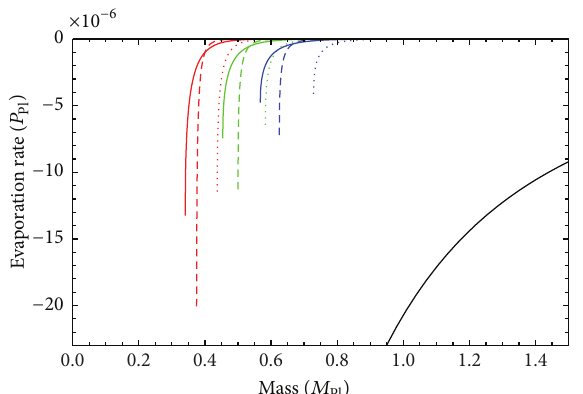
Figure 9: The evaporation rate versus the black hole mass for the case 𝑛 = 2 . From left to right: GUP 2 result (solid curve), GUP 0 result (dashed curve), and GUP 1 result (dotted curve) for 𝛼 = 0.75 (red), 𝛼 = 1 (green), and 𝛼 = 1.25 (blue), respectively, and the Hawking result (black solid curve) at the lower right corner.